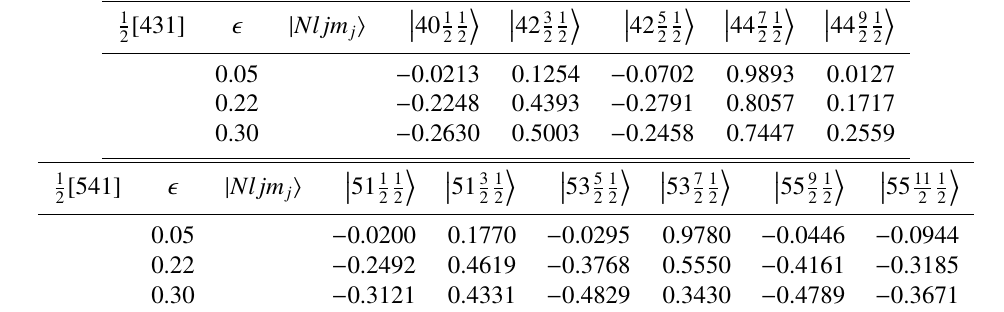
Table 5. Expansions of Nilsson orbitals K [ Nn z Λ ] in the shell model basis | Nljm j (cid:105) for three di ff erent values of the deformation (cid:15) . The Nilsson orbitals shown do not possess the highest total angular momentum j in their shell. The existence of a leading shell model eigenvector is evident at small deformation, but this is not the case any more at higher deformations, at which several shell model eigenvectors make considerable contributions. Adapted from Ref.